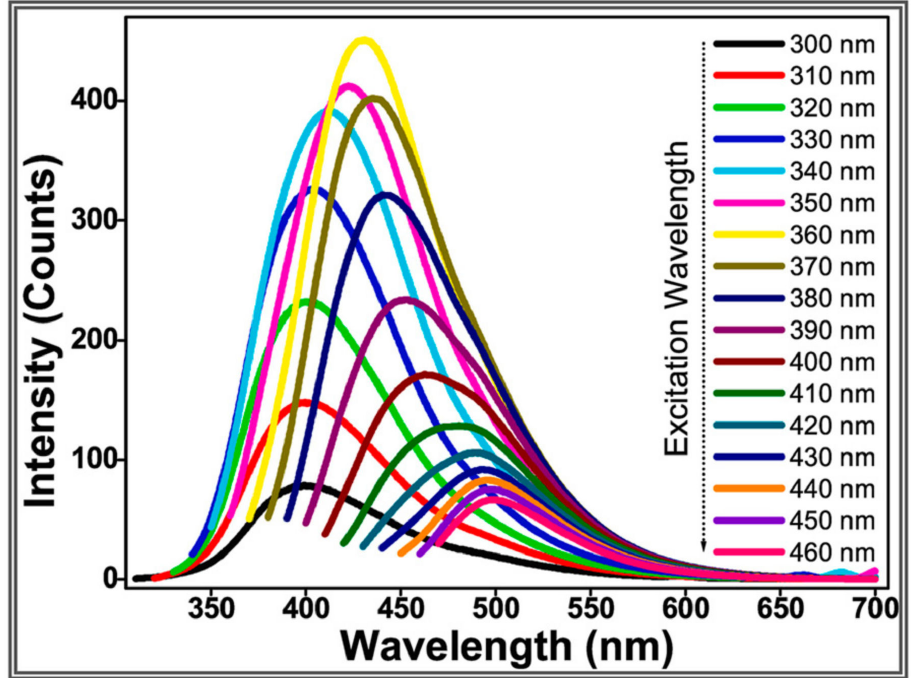
Figure 9. Fluorescence emission spectra at different excitation wavelengths of CQDs prepared from kiwifruit peels. Adapted with permission from [111], Copyright {2022}, Elsevier. Heteroatom doping, surface functionalization, and surface passivation of CQDs are known to induce surface-state mechanisms. Heteroatom doping is a common method in the preparation of CQDs and allows their intrinsic properties to be tuneable and exploited for their desired potential applications. Elements such as N, B, S, and P are used as a dopants to replace carbon atoms in the sp 2 /sp 3 network [109]. Surface functionalization is related to the introduction of functional groups via covalent bonding on the carbon edge planes [112]. glycol (PEG), amine terminated polyethylene glycols (PEG-1500N),